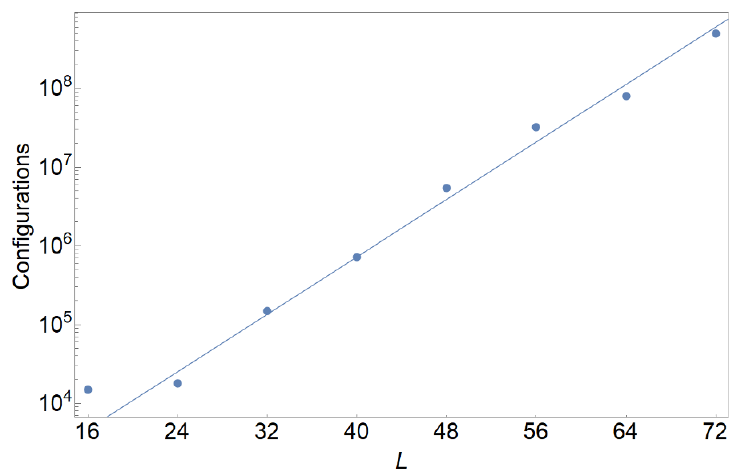
Figure 1 . The number of con(cid:12)gurations needed for retaining a constant relative precision as a function of lattice size for an unmodi(cid:12)ed contour grows exponentially as e 0 : 21 L . The sign problem is